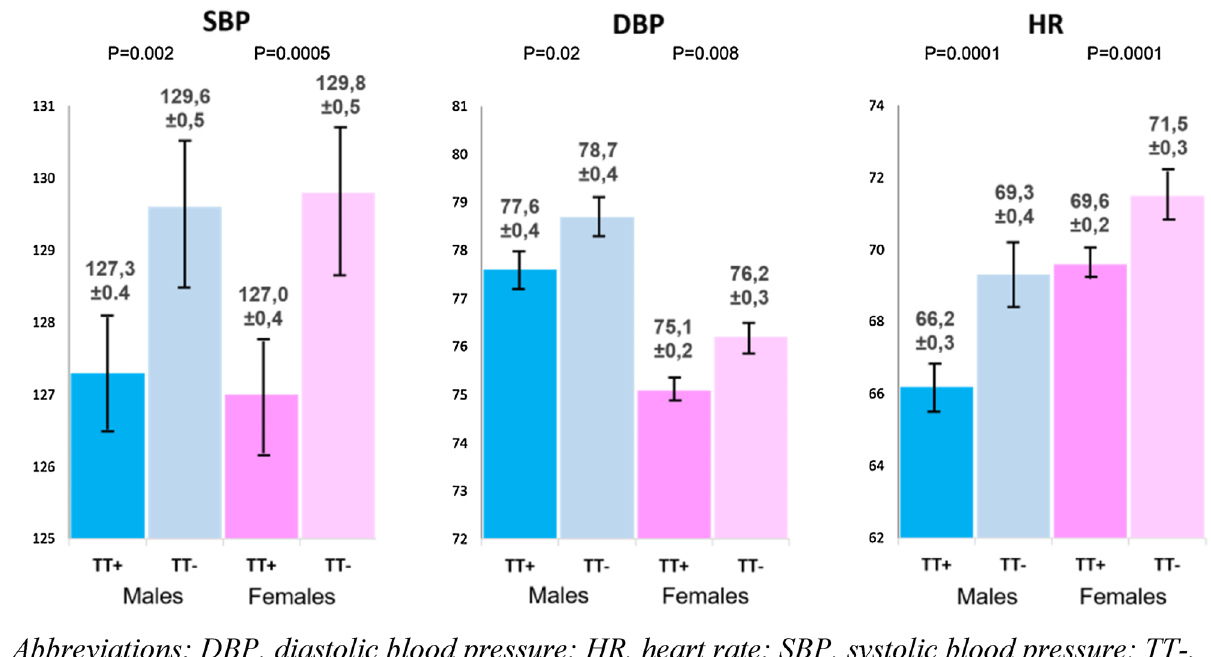
Figure 1. Gender-stratified systolic blood pressure, diastolic blood pressure and heart rate in tilt-positive and tilt-negative patients. DBP diastolic blood pressure; HR heart rate; SBP systolic blood pressure; TT− tilt-negative; TT + tilt-positive. Resting systolic blood pressure, diastolic blood pressure and heart rate among tilt-positive and tilt-negative patients stratified by gender who were investigated using Italian tilt-test protocol for suspected syncope. Males, tilt-positive, n = 1428, tilt-negative, n = 923; females, tilt-positive, n = 1701, tilt-negative, n = 2107. All the values are shown as mean ± 1 SE. The bars show the ± 95% confidence limit (2 SEs).